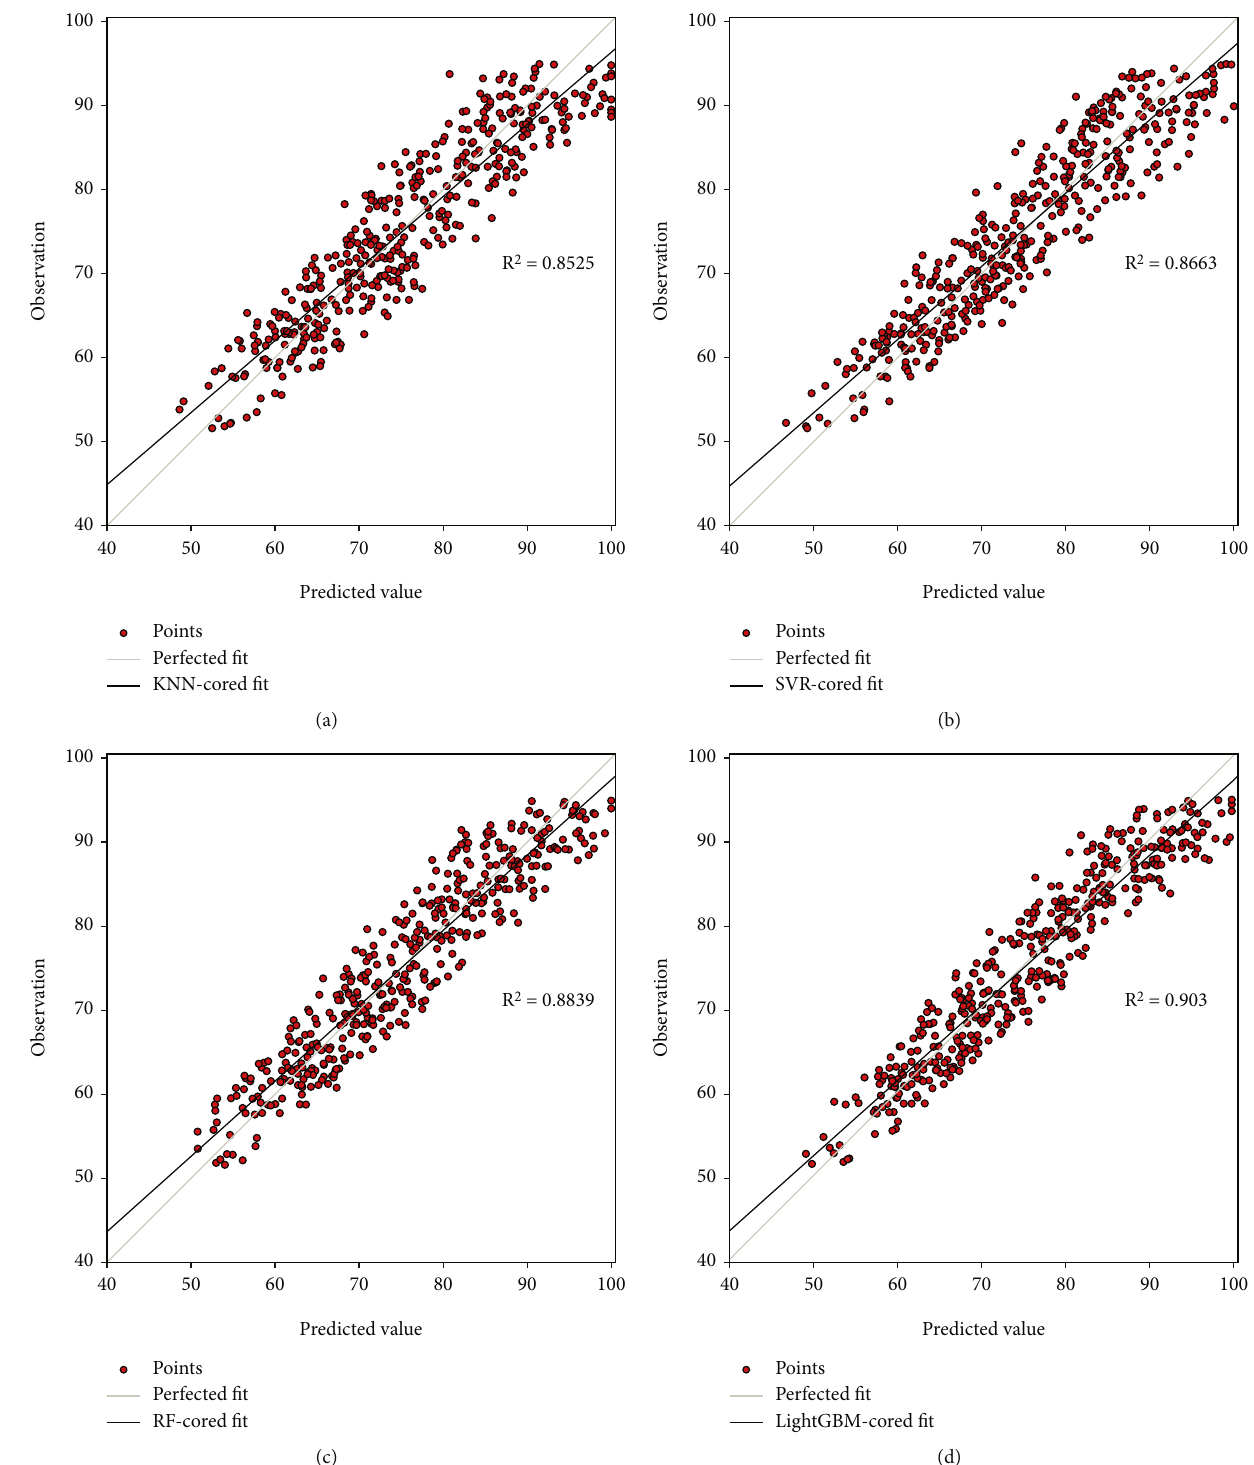
Figure 11: Fitness of water saturation results provided by KNN-cored predictor (a), SVR-cored predictor (b), RF-cored predictor (c), and LightGBM-cored predictor (d) in the fi rst experiment. KNN =k-nearest neighbors; SVR =support vector regression; RF=random forest; LightGBM=light gradient boosting machine; RMSE =root-mean-square